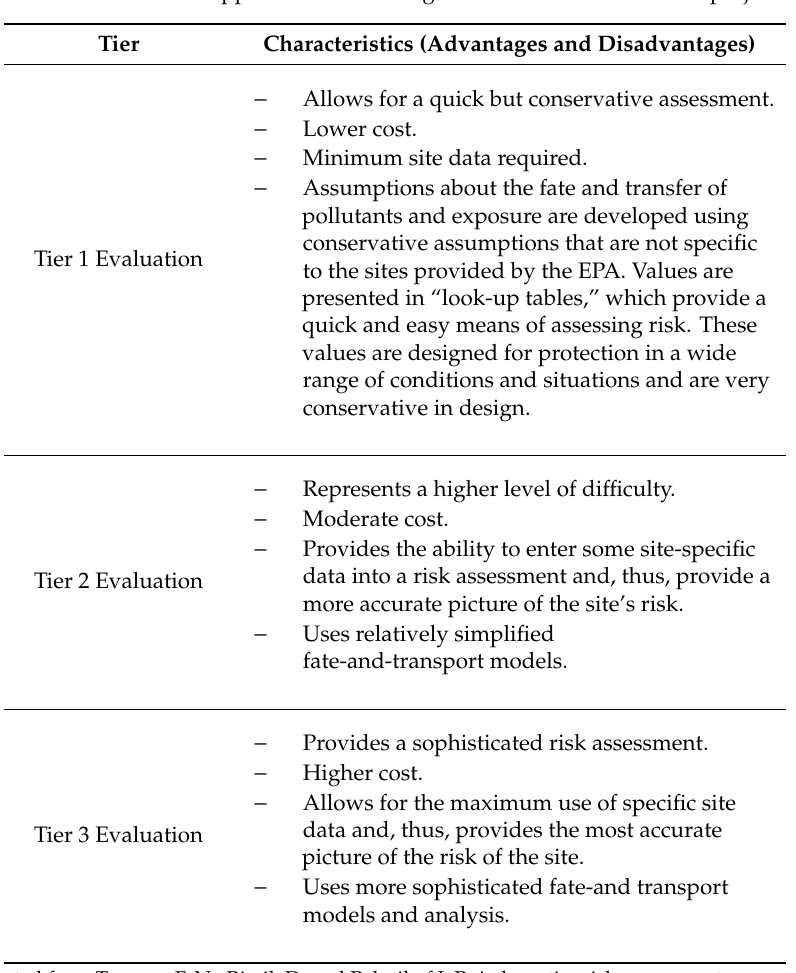
fate-and-transport models. − Provides a sophisticated risk assessment. − Higher cost. − Allows for the maximum use of specific site data and, thus, provides the most accurate Tier 3 Evaluation picture of the risk of the site. − Uses more sophisticated fate-and transport models and